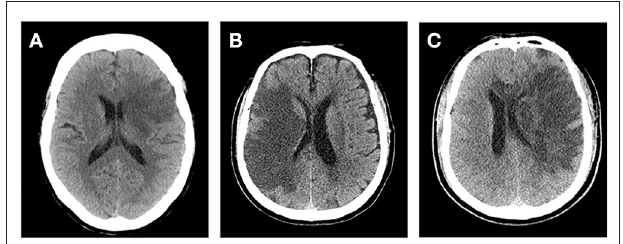
FIGURE 1 | Cerebral edema grades. (A) Left frontal lobe and basal ganglia brain swelling, < 1/3 of the hemisphere. (B) Right frontal and parietal lobe brain swelling, > 1/3 of the hemisphere and without midline shift (MLS). (C) Left cerebral hemisphere swelling, > 1/3 of the hemisphere with